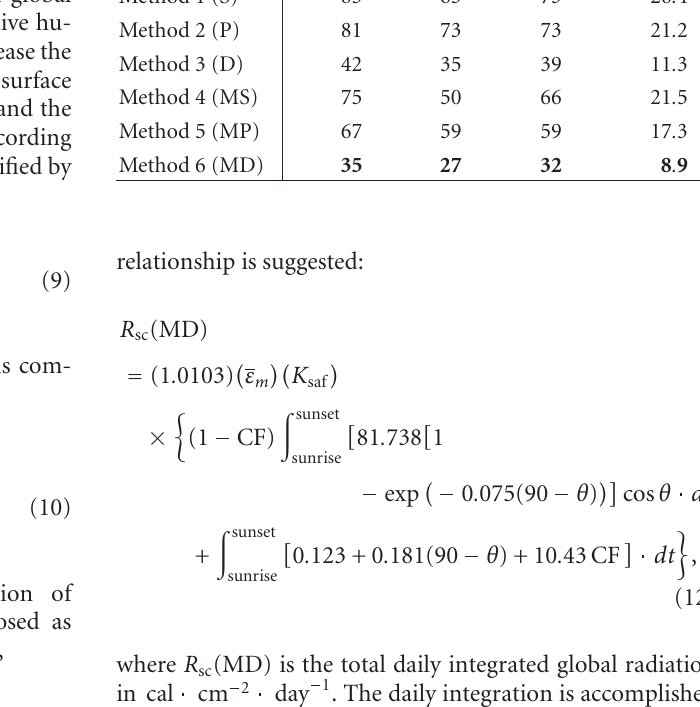
ries of dataset consist of up to 12 (months) 156 data). For each method, the errors are computed using measured total monthly global radiation observed at 4 solar radiation sites. The minimum, maximum, and mean errors are given in Table 2. For northern city (Ramsar) where the climate condition is di ff erent from southern coast, the errors are shown in Table 3. In evaluating the model results, only mean errors are